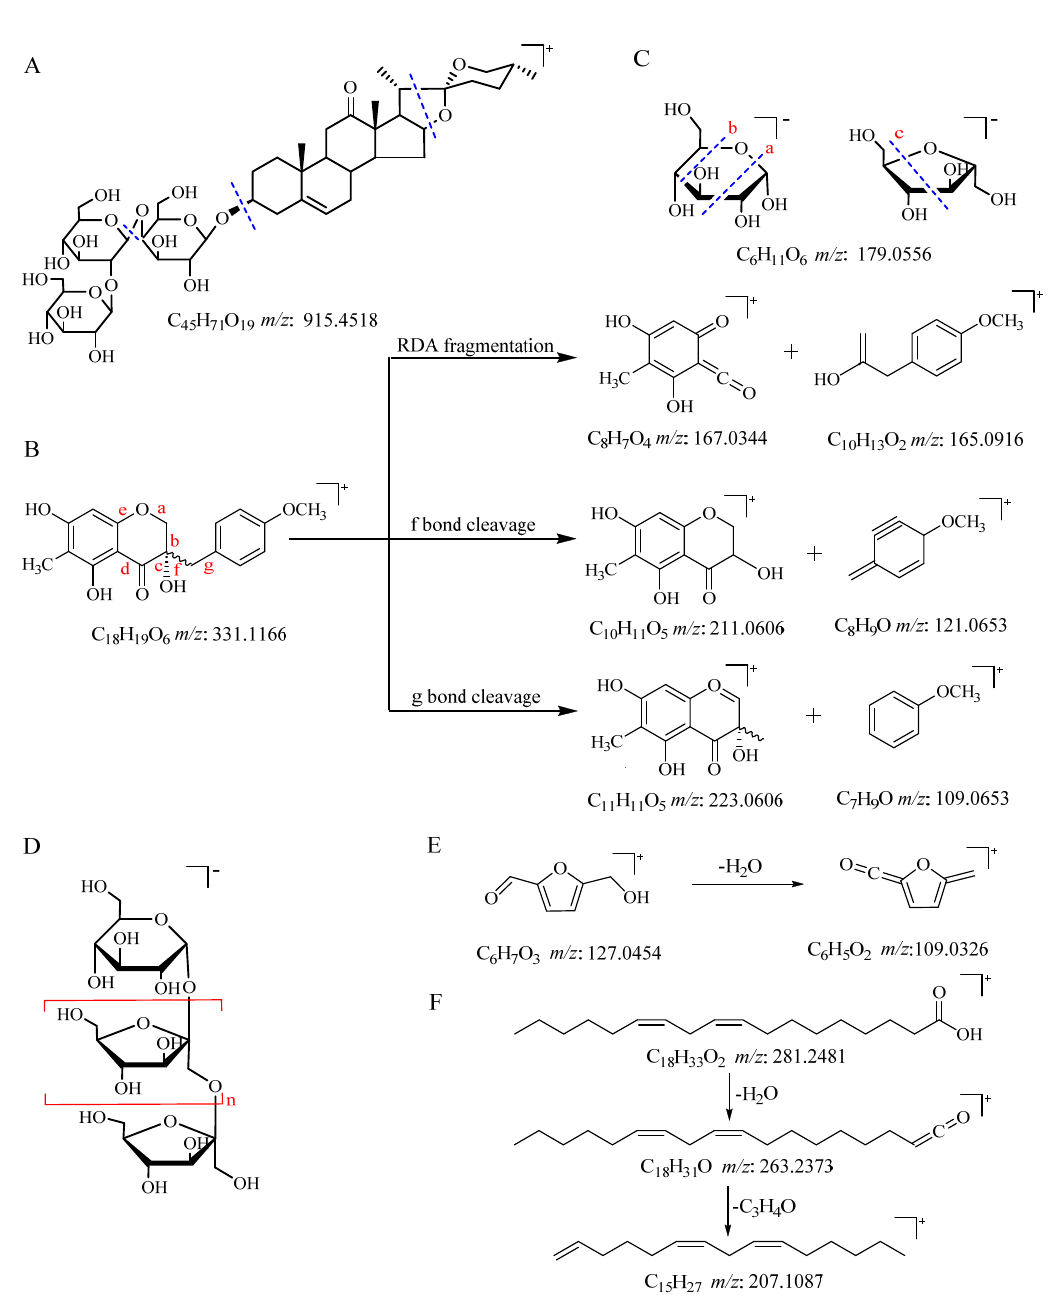
Figure 2. ( A ) The fragmentation regularity of pratioside D 1 ; ( B ) ( 3S)-3,5,7-trihydroxy-6-methyl-3-(4 ′ - Figure 2. ( A ) Fragmentation regularity of pratioside D 1 . ( B ) (3S)-3,5,7-trihydroxy-6-methyl-3- methoxybenzyl) chroman-4-one; Glucose and ( C ) D-fructose; ( D ) Inulin-type oligosaccharides; ( E ) 5- (4 (cid:48) -methoxybenzyl) chroman-4-one Glucose and ( C ) D-fructose. ( D ) Inulin-type oligosaccharides Hydroxymethylfurfural; ( F ) Linoleic acid. ( E ) 5-Hydroxymethylfurfural and ( F ) Linoleic